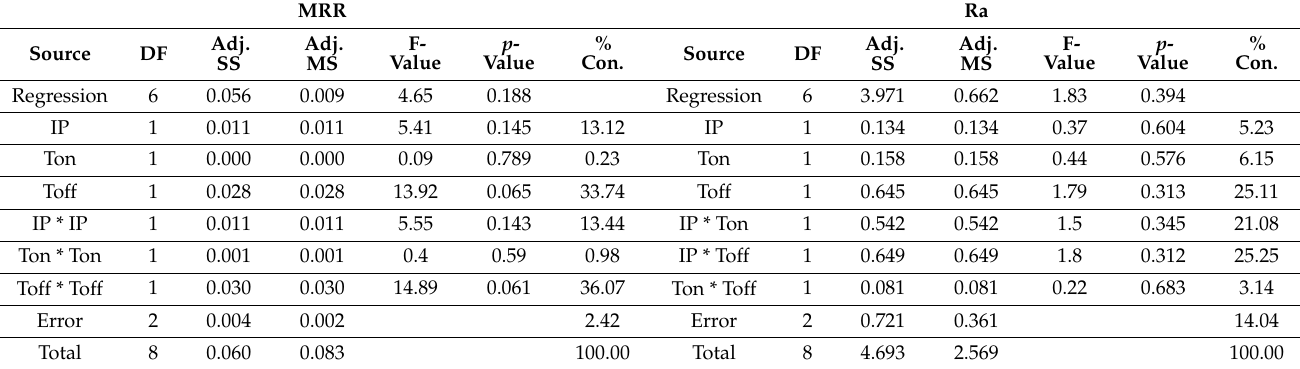
Table 6. Analysis of variance for the cryogenically treated